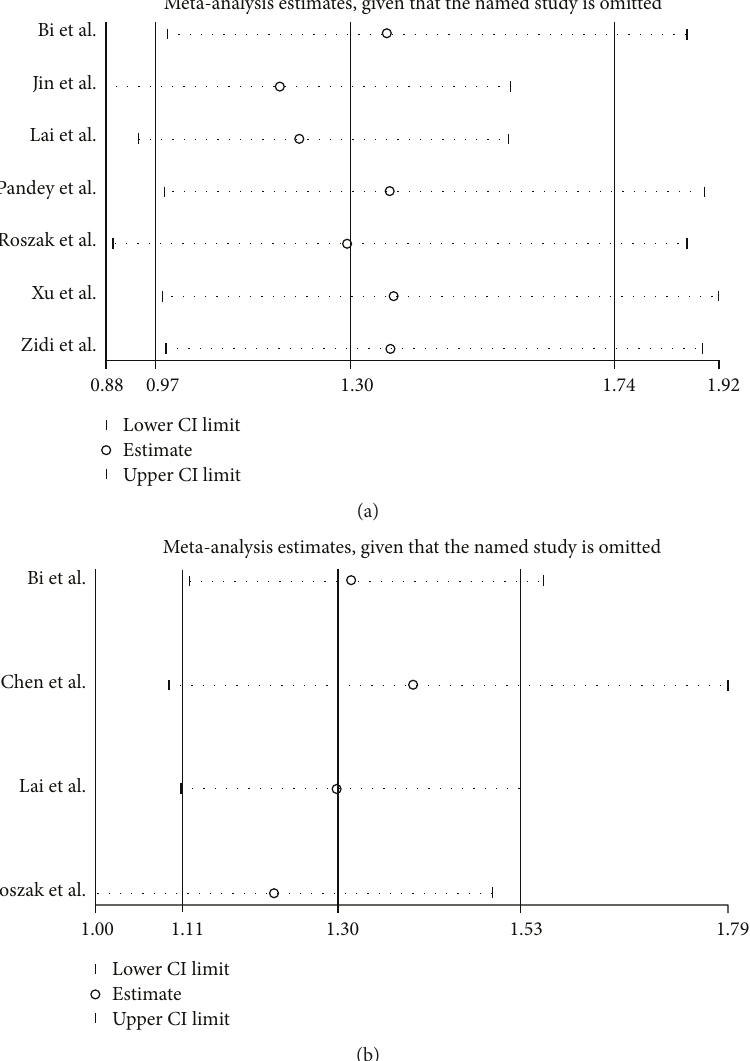
Figure 7: Sensitivity analysis of the association between TLR9 SNPs and risk of cervical cancer in the dominant genetic model. (a) rs352140. (b)